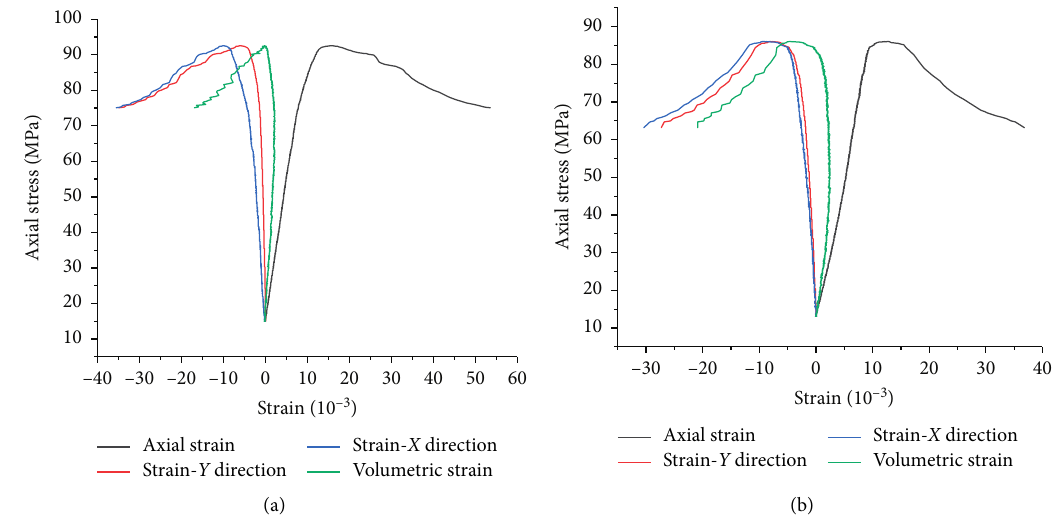
Figure 11: Mining-induced mechanical characteristic curves of different protective layer mining modes. (a) Soft rock. (b) Coal seam.